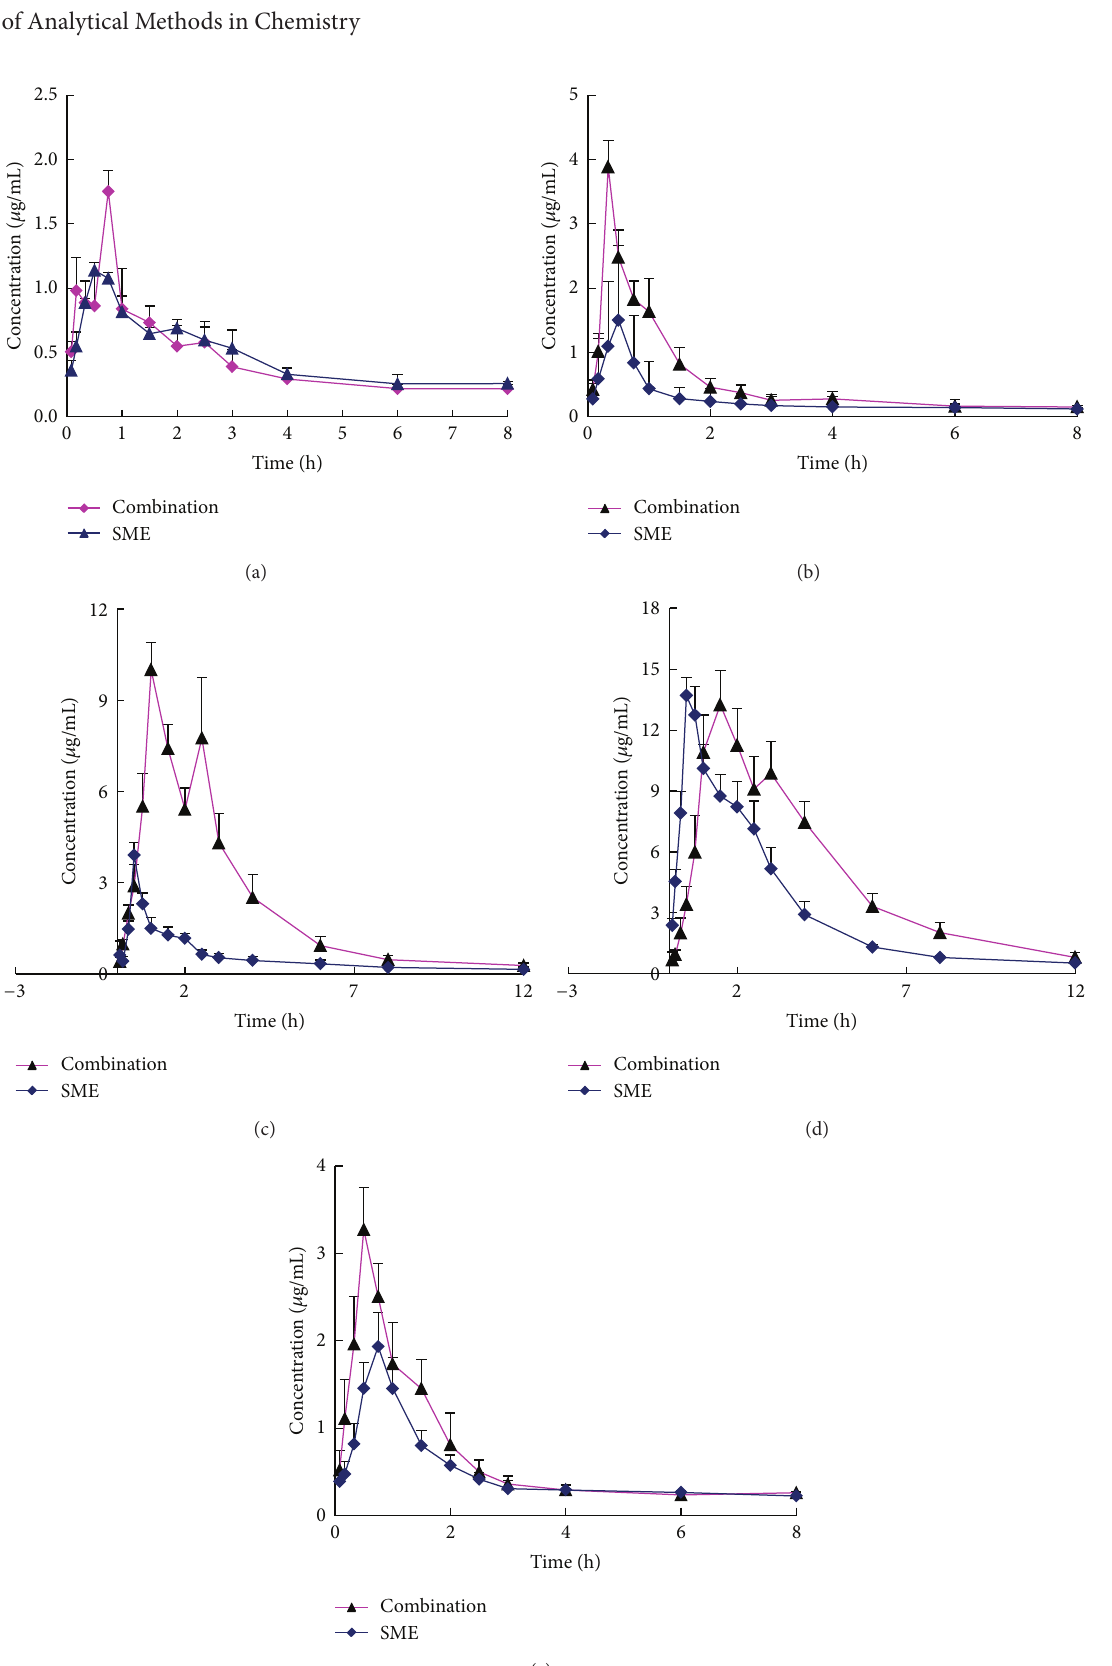
Figure 3: Mean concentration-time profiles of DSS (a), RA (b), LA (c), SAB (d), and HP (e) in rat plasma after oral administration of a single extract and a combination of both